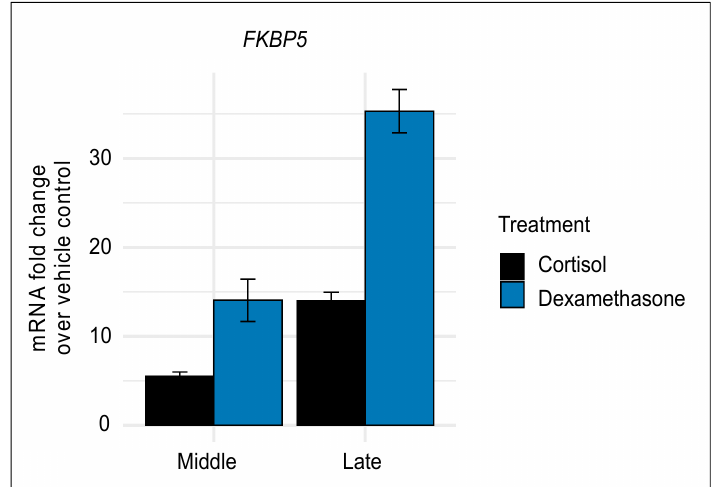
concentrations of either cortisol or dexamethasone is not su ffi cient to accelerate telomere shortening in cultured human fibroblasts.